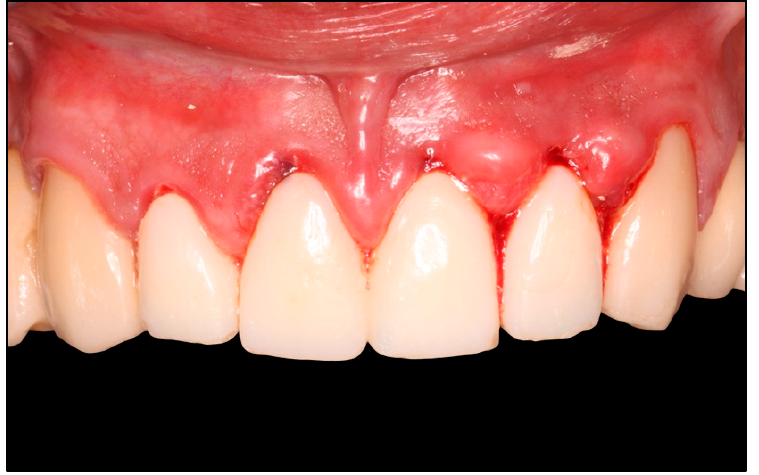
Figure 3. Adaptation of the provisional crowns 1 mm below the gingival margin to prevent invasion into the supracrestal space.